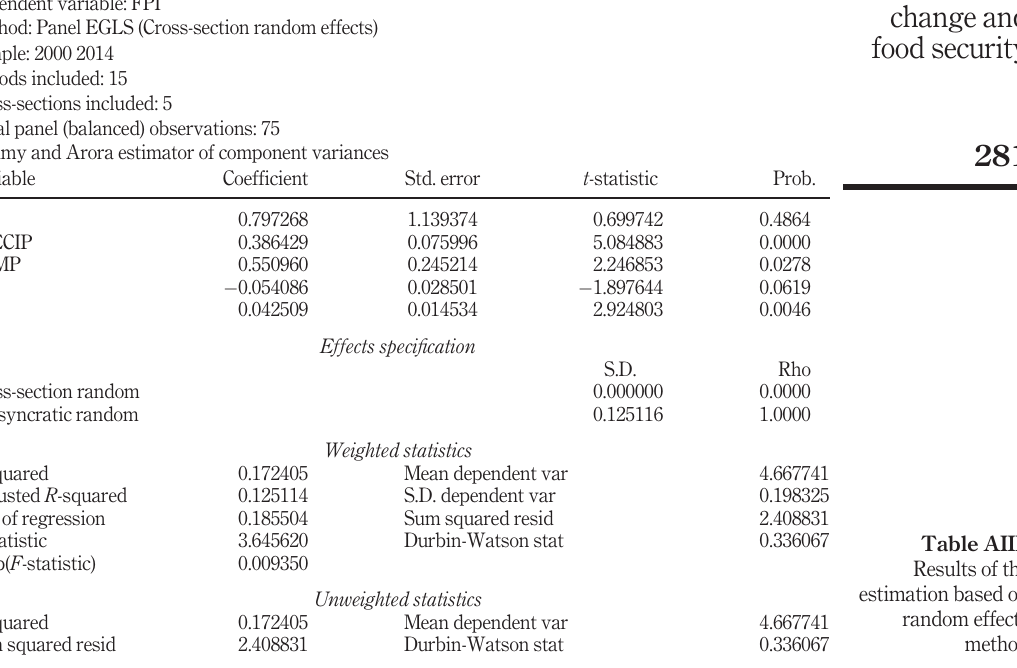
Table AIII. Results of